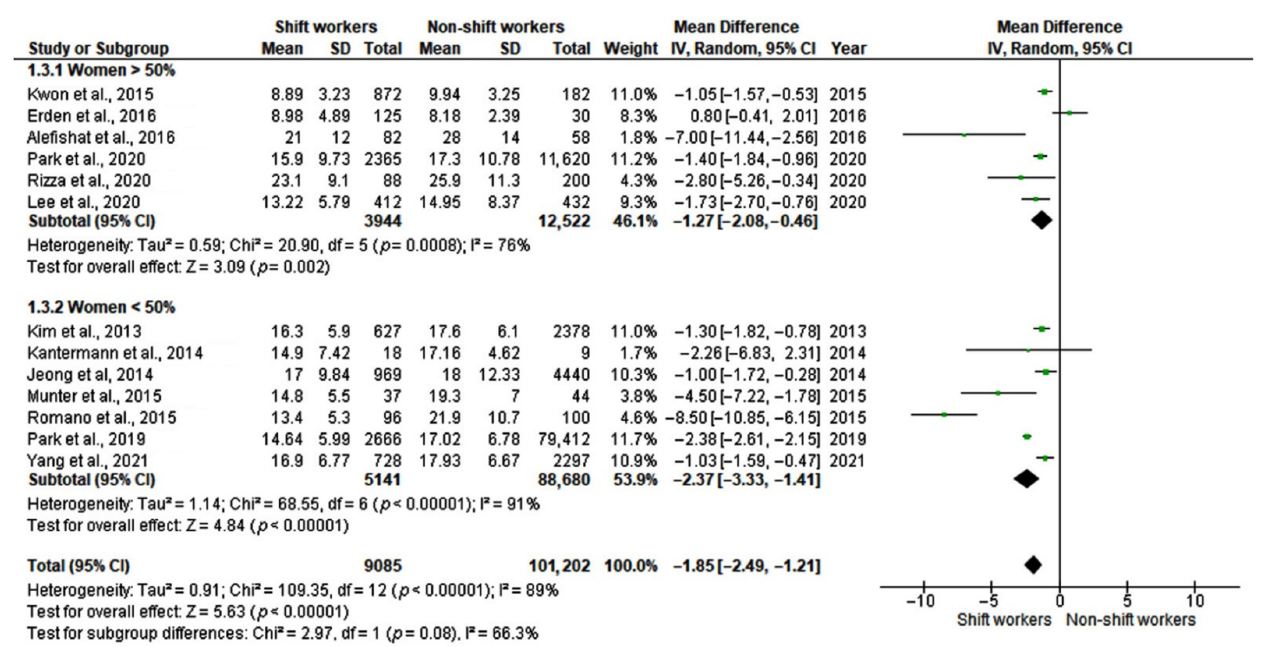
Figure 6. Forest plots showing mean differences in serum 25-hydroxyvitamin D (25-OH-D) levels (ng/mL) in shift workers and non-shift workers (subgroup 2: gender prevalence) [12,24–35].